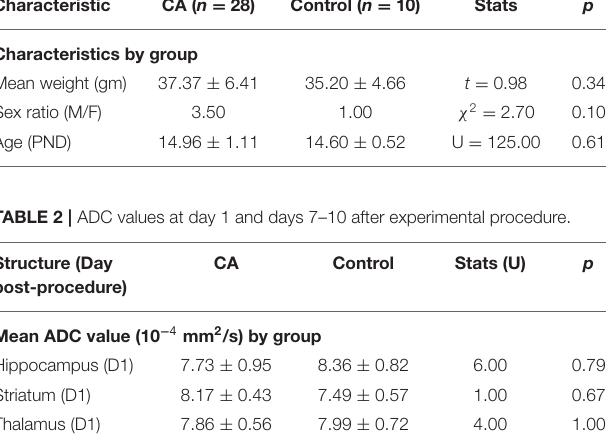
FIGURE 2 | Photographs of coronal brain slices obtained from a control rat (A , B) and a rat previously subjected to a cardiac arrest (CA) (C , D) at the level of the substantia nigra pars compacta (SNPc; A , C ) and the hippocampal region (B , D) . Slices were stained with cresyl violet. Note the absence of any major anatomical damage in the CA